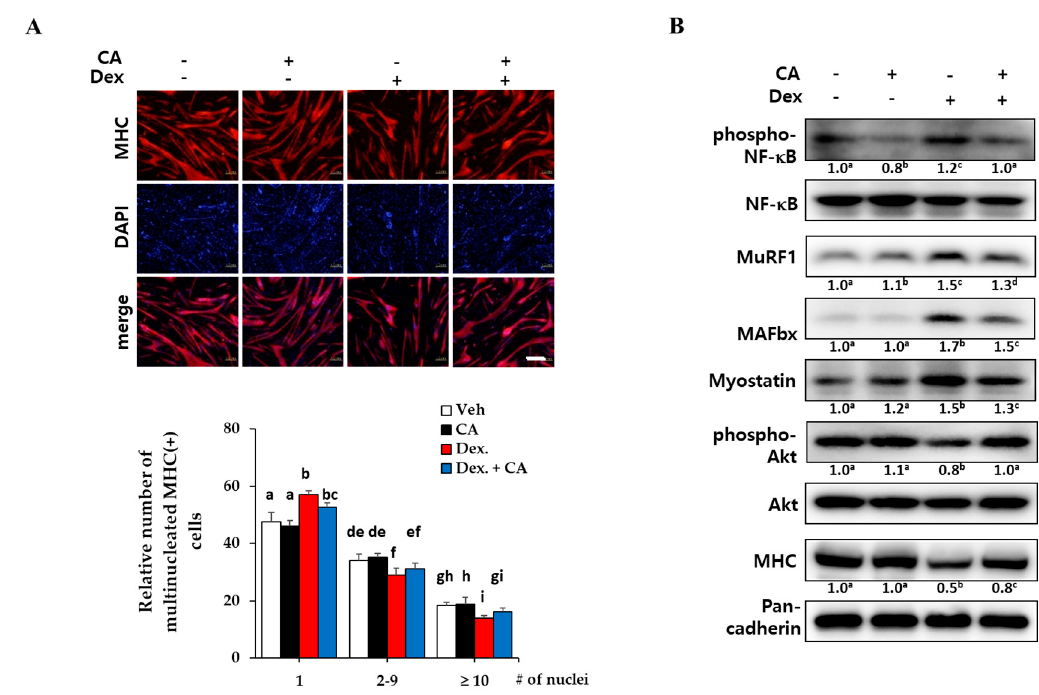
Figure 5. Protective e ff ects of corylifol A against dexamethasone-induced myotube atrophy in vitro. C2C12 myoblasts were di ff erentiated for 3 days, followed by treatment with dexamethasone (Dex, 1 µ M) along with vehicle DMSO or corylifol A (CA, 100 nM) for an additional 48 h. ( A ) Collected cells were fixed and immunostained with MHC (red) and DAPI (blue) (scale bar = 200 µ m). ( B ) Cell lysates were subjected to Western blot analysis to analyze phosphorylated NF- κ B, E3 ligases, myostatin, phosphorylated Akt and MHC. Values are mean ( n = 3). The images are representative of three independent experiments with similar results. Means without a common superscript di ff er significantly ( p < 0.05).